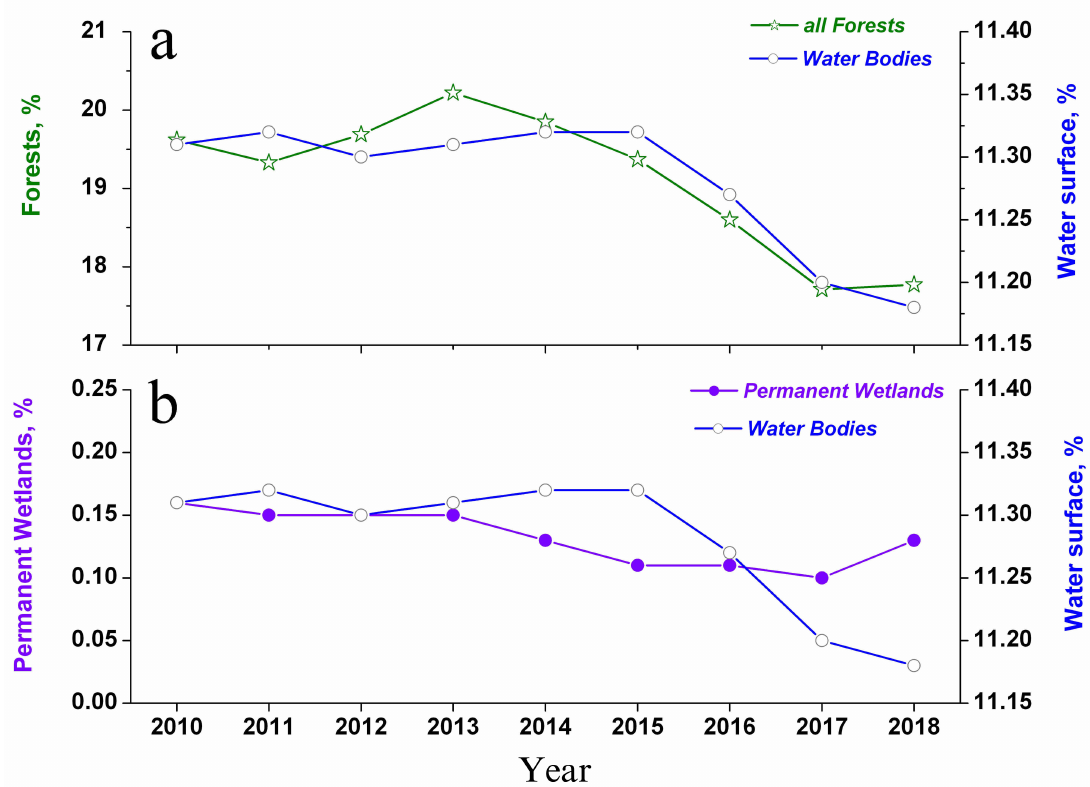
Figure 3. The interannual variability of areas occupied by forests ( a ) and by swamp systems ( b ), as a percentage of the Russian basin of the Lake Baikal as a function of time for the period 2010–2018, considered in this paper. The area of water surface is presented for comparison. The vegetation types in MCD12C1 correspond to IGBP